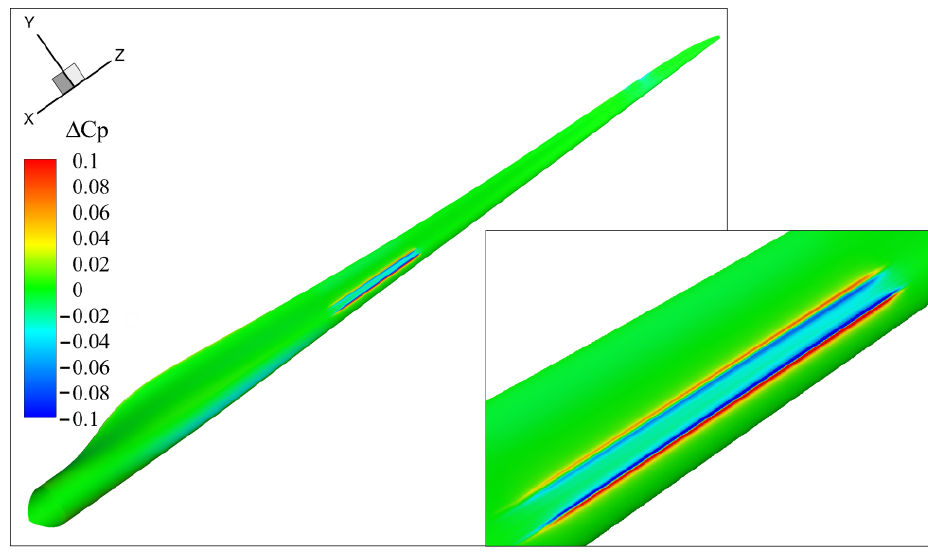
Figure 22. Differential pressure coefficient field of the repaired blade and original blade.